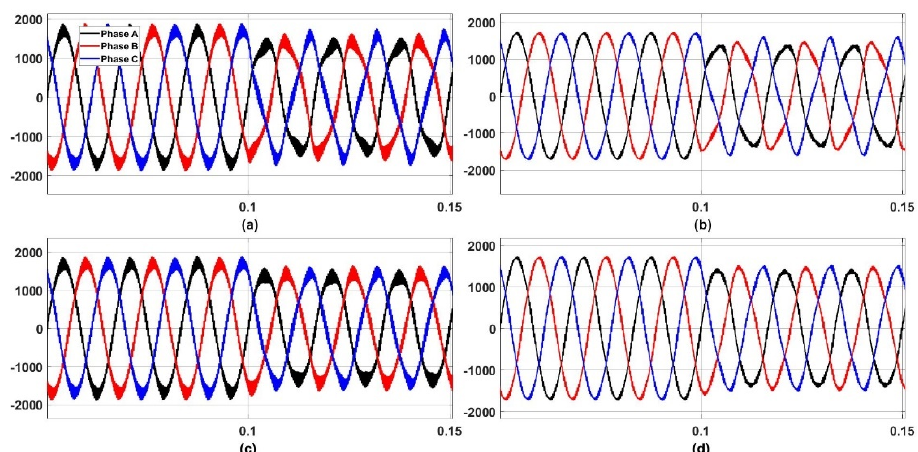
Figure 25. Three-phase pcc voltages in an unbalanced swell in the case of ( a ) 2L- αβ , ( b ) 3L- αβ , ( c ) 2L-dq and ( d ) 3L-dq .